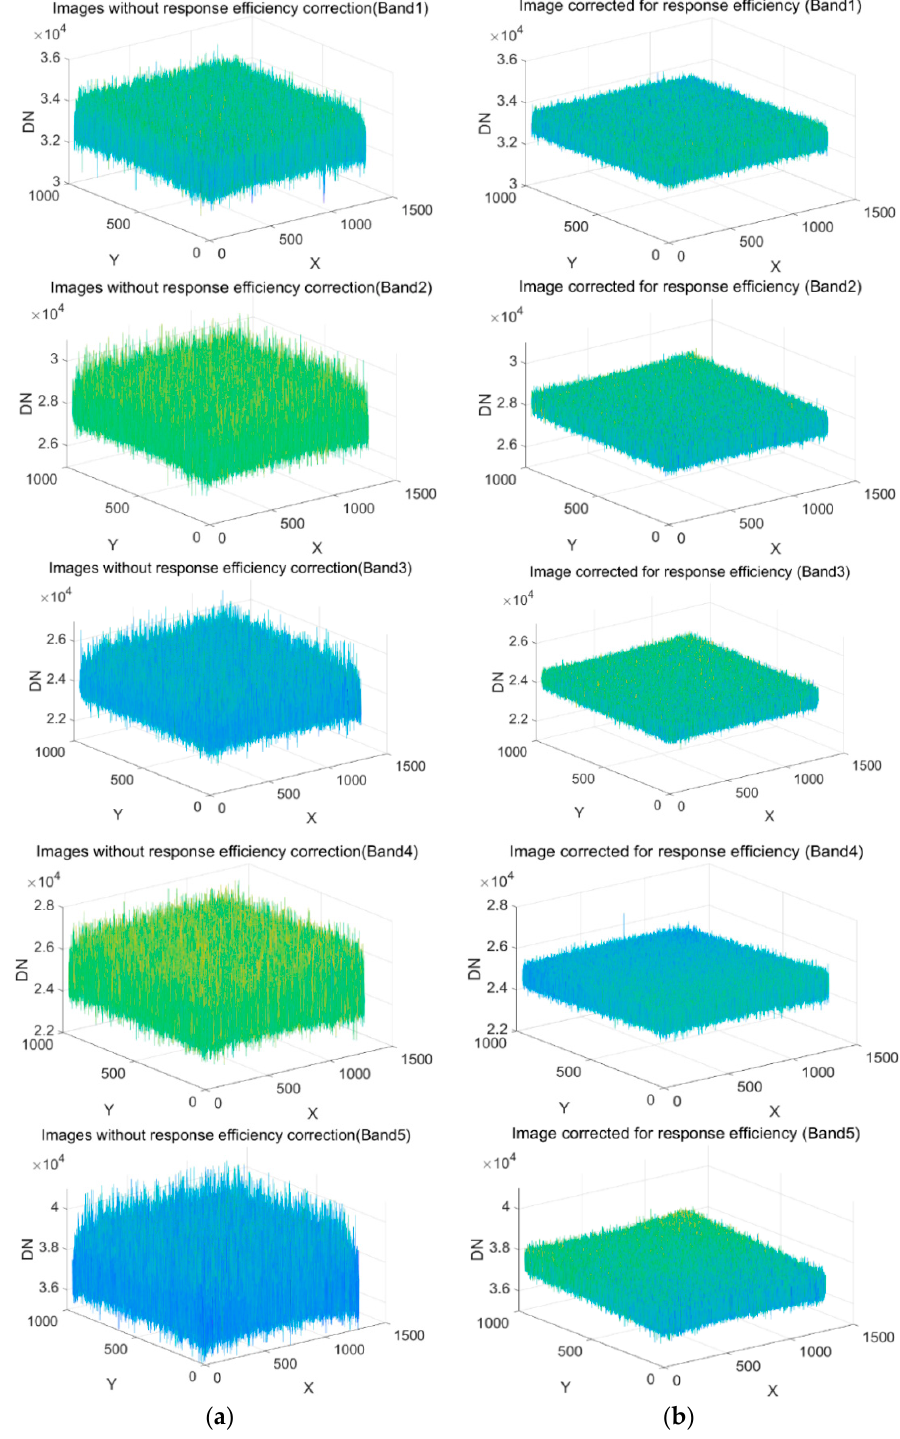
Figure 15. Comparison of response correction between ( a ) the images corrected for dark current and vignetting effect but not for the non-uniform response (Band1-Band5) and ( b ) the images are corrected for dark current, vignetting effect, and non-uniform response (Band1-Band5).